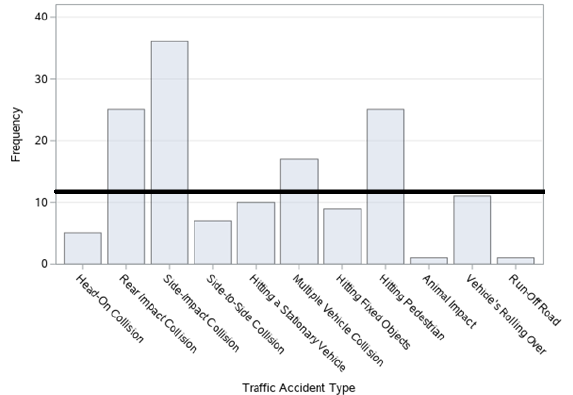
Figure 13. Bar graph of traffic accidents on Cumhuriyet Street in Şişli district by accident type. When the